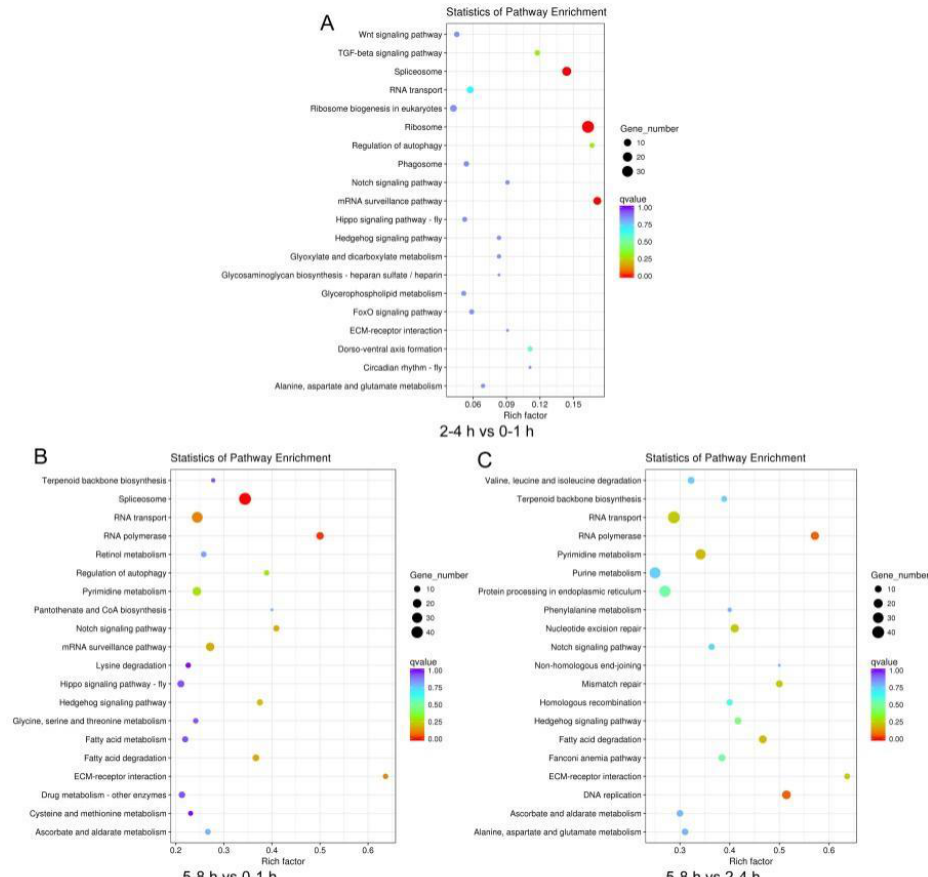
Figure 5. Kyoto Encyclopedia of Genes and Genomes (KEGG) pathway classification for differentially expressed unigenes (DEGs) during the early embryo transcriptomes of B. dorsalis . ( A ) KEGG significant enrichment analysis for the DEGs between 2–4 and 0–1 h. ( B ) KEGG significant enrichment analysis for the DEGs between 5–8 and 0–1 h. ( C ) KEGG significant enrichment analysis for the DEGs between 5–8 and 2–4 h.